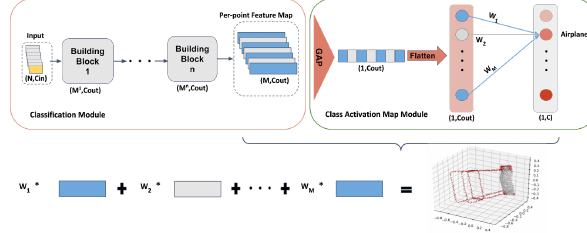
Figure 2: Illustration of the proposed 3DCAM: the predicted class score is mapped back to the previous last layer to generate the class activation maps (CAMs). The CAM highlights the class-specific discriminative